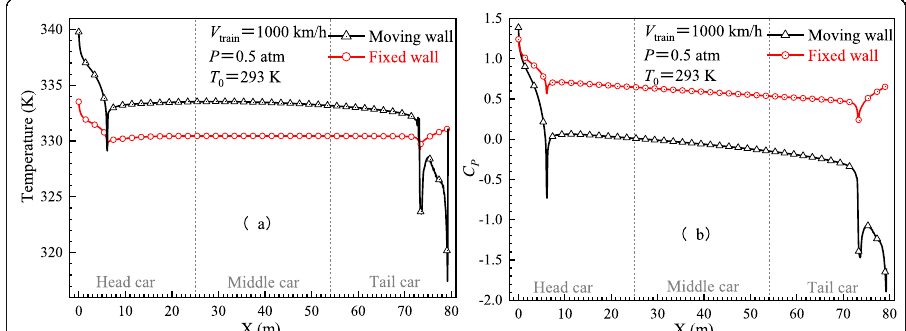
Fig. 5 Temperature and pressure coefficient ( C P ) distribution on the intersection line between the train upper surface and the xy plane: a Temperature distribution; b C P